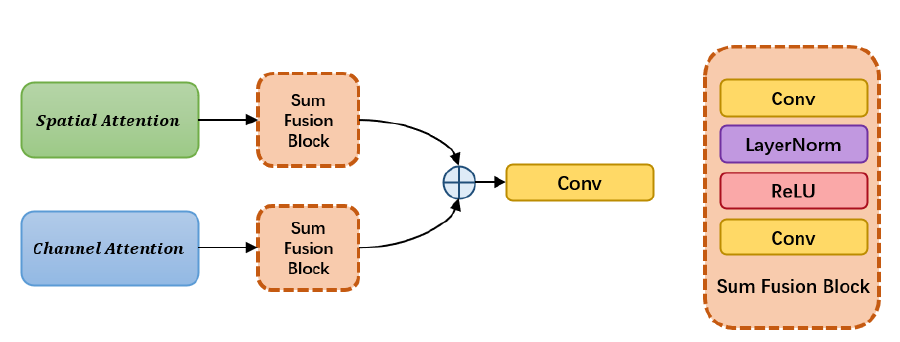
Figure 5. The structure of SumFusion modular.